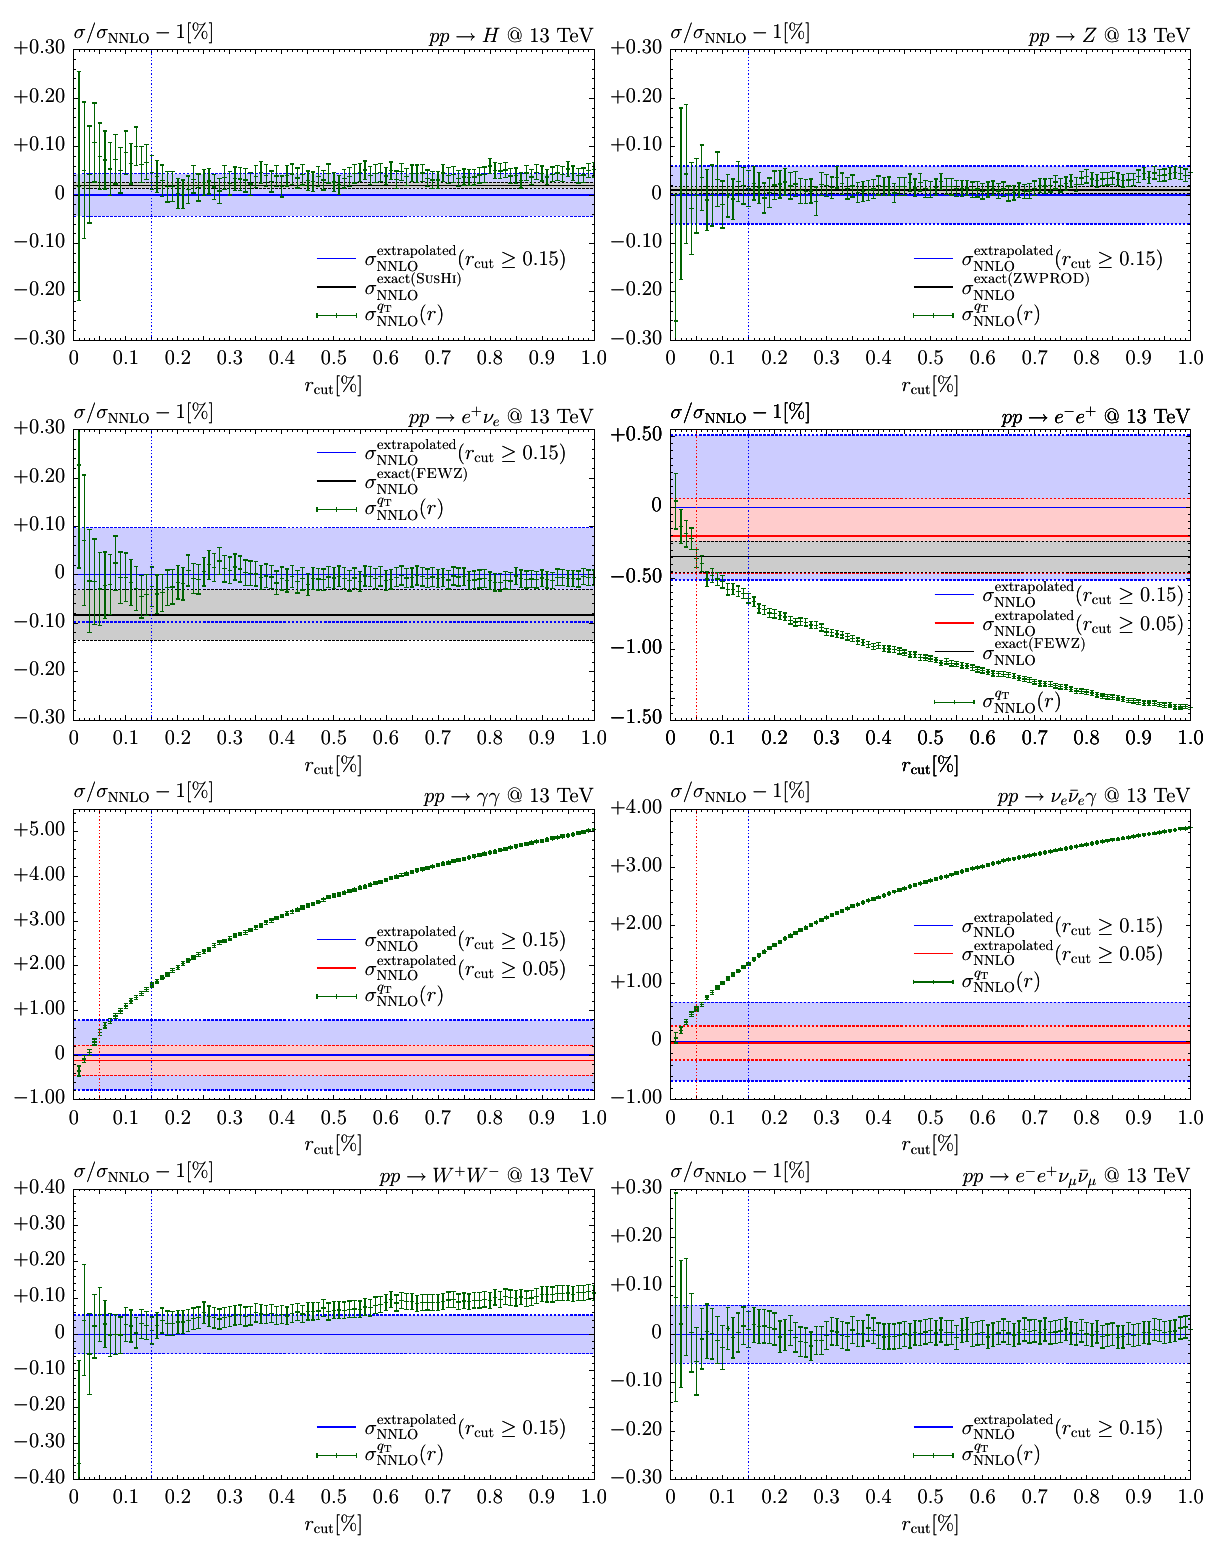
Fig. 2 Dependence of the NNLO cross sections on r cut for various processes. The NNLO results at fixed values of r cut are normalized to the r cut → 0 extrapolation obtained by using r cut ≥ 0 . 15%. The blue band represents the combined numerical and extrapolation